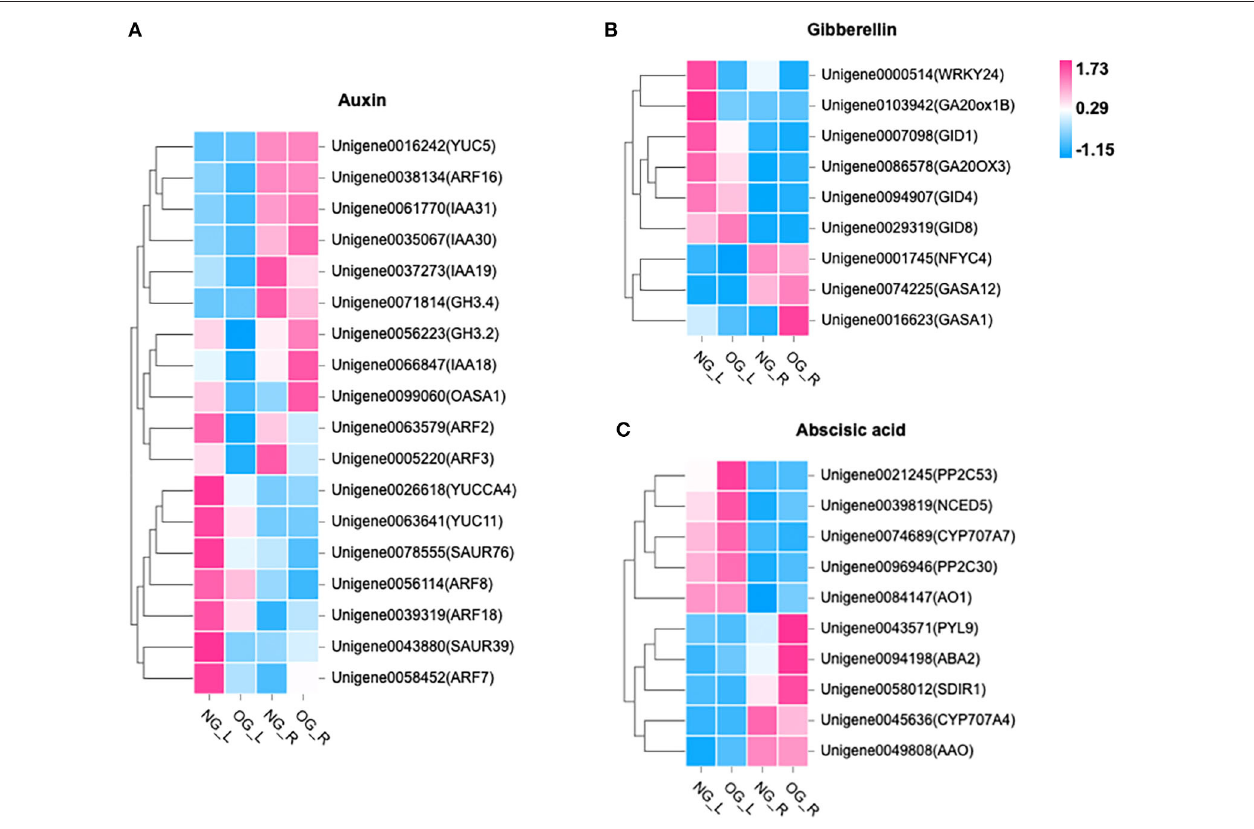
FIGURE 4 | Changes in the expression of genes in response to long-term OG stress. The heat map shows the relative transcript levels of selected biosynthetic, metabolic, and signaling genes for (A) IAA, (B) ABA, and (C) GA. NG_L, leaf of no-grazing; NG_R, root of no-grazing; OG_L, leaf of overgrazing; OG_R, root of overgrazing.